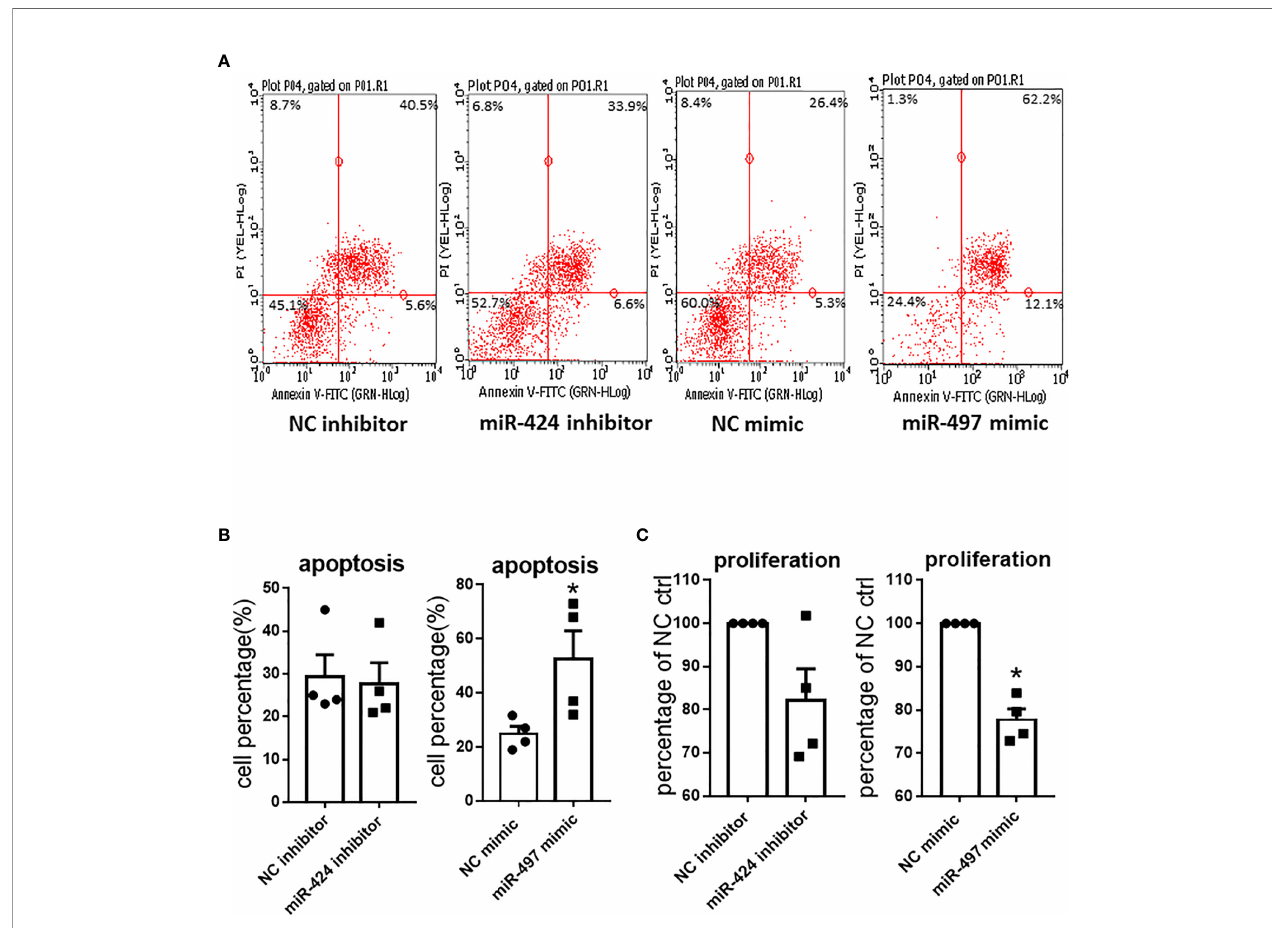
FIGURE 4 | Apoptosis and proliferation result caused by gain or loss of miR-424 and miR-497 function in RASF. (A) Flow cytometry representative images of Annexin V-FITC and PI double staining after transfected with 100 nM miR-424 inhibitor and 10 nM miR-497 mimic for 24 h. Four quadrants represent viable cells; early apoptotic cells, late apoptotic cells and dead cells. (B) Percentage of apoptotic cells in transfected cells. (C) Proliferation result detected by cell counting kit-8 assay (CCK8) after transfected with 100 nM miR-424 inhibitor and 10 nM miR-497 mimic for 72h. RASF cells isolated from synovial tissue of 4 RA patients were transfected with miR-424 inhibitor or miR-497 mimic, respectively. Bar: mean ± SEM of samples from 4 patients. *: P < 0.05 using the Mann-Whitney U